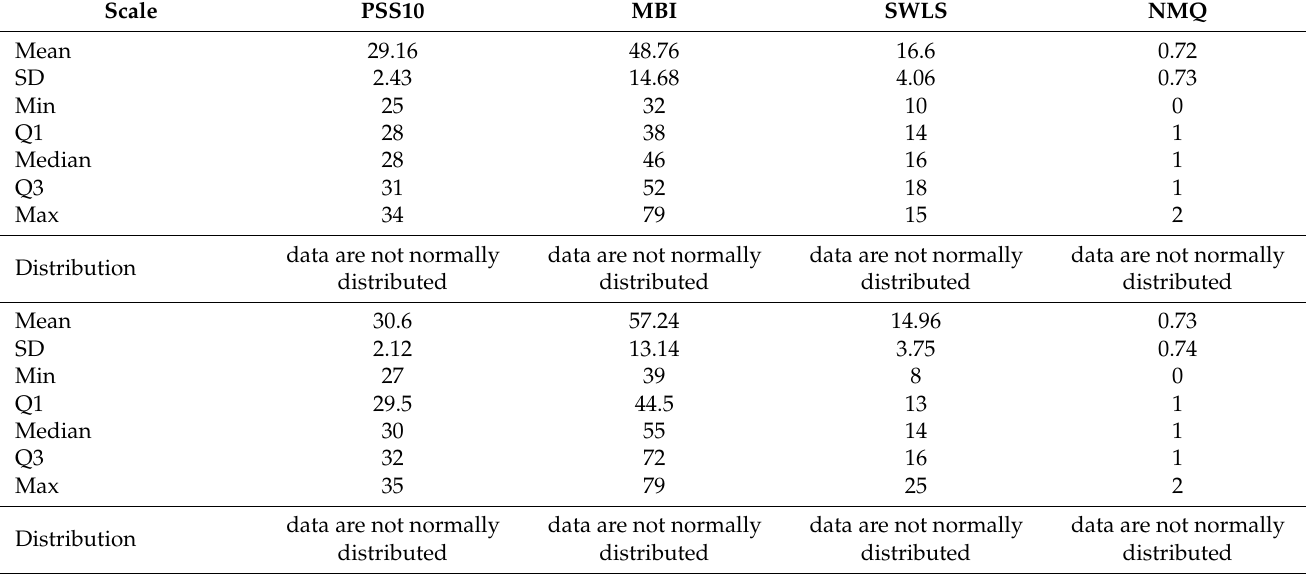
Table 4. Results for the study group.